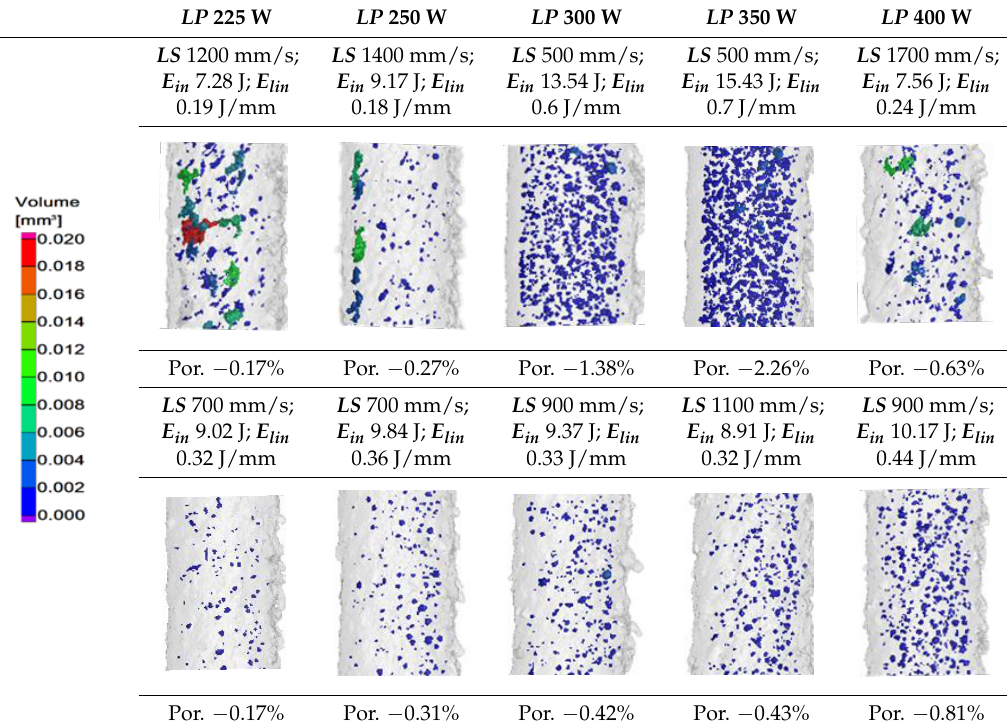
Table 2. The porosity level of the strut samples—3D renders with pores shape; the pores in the entire volume were projected to the plane of the view; all images have the same pores scale bar.